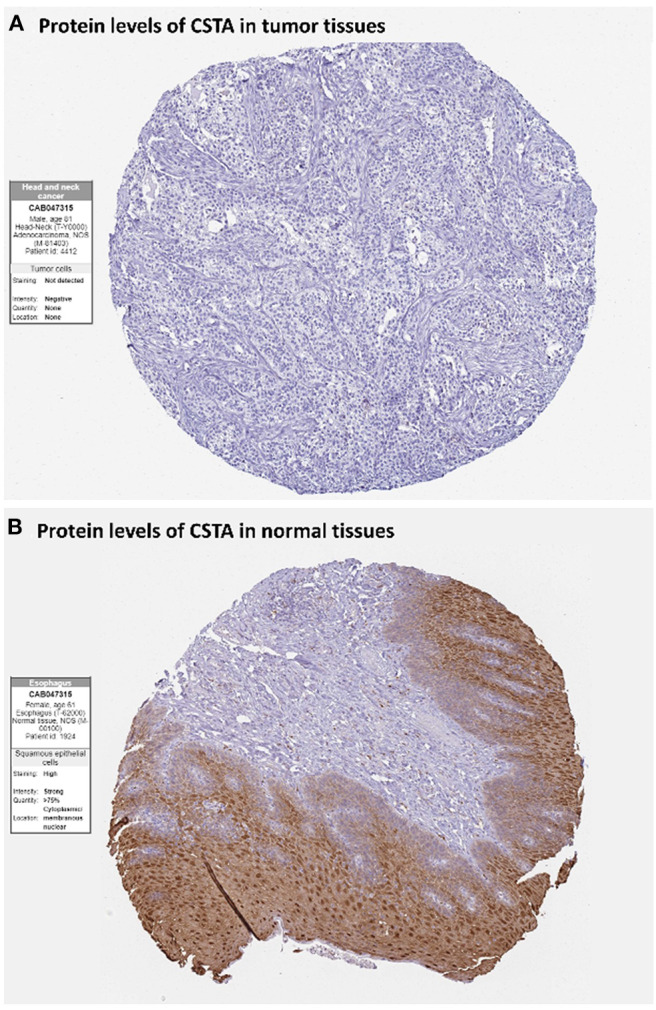
Immunohistochemistry of the CSTA gene in HNSCC and normal tissues from the human protein atlas (HPA) database. (A) Protein levels of CSTA in HNSCC tissues (antibody CAB047315; staining: not detected; intensity: negative; quantity: none). (B) Protein levels of CSTA in normal oral mucosa tissues (antibody CAB047315; staining: high; intensity: strong; quantity: >75%).